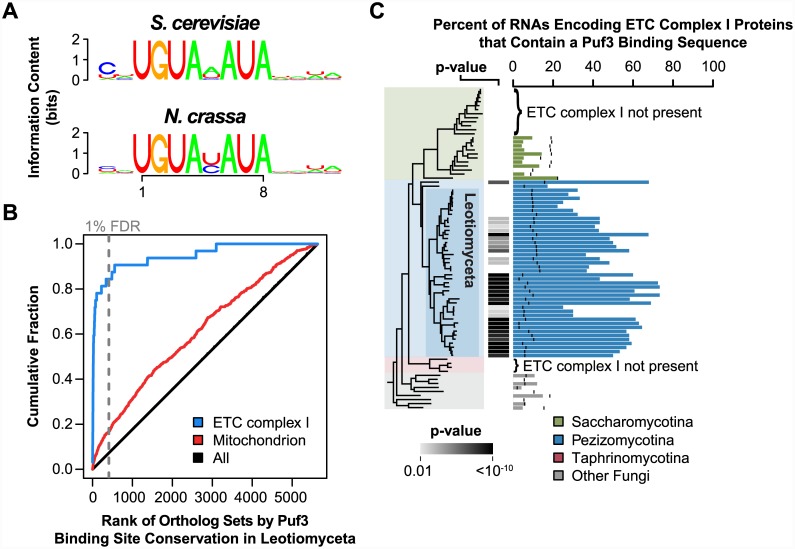
Binding specificity and targets of Leotiomyceta Puf3.(A) Motifs identified by the motif discovery program FIRE [82] within the 3' UTRs of S. cerevisiae mRNAs associated with S. cerevisiae Puf3 or the ectopically expressed N. crassa Puf3. FIRE identified eight nucleotide motifs, and these motifs were extended to display any preferences for flanking nucleotides. A match to the Puf3 motif UGUA[ACU]AUA is found in the 3' UTRs of 241 out of 392 (61%) of S. cerevisiae Puf3 targets and 83 out of 250 (33%) of mRNAs associated with N. crassa Puf3. The motif frequency across all 3' UTRs is 11%. Position frequency matrices can be found in S5 Dataset. (B) Cumulative distributions based on the ranked conservation score for Puf3 sites across Leotiomyceta species. The gray dashed line represents the 1% false discovery rate (FDR) cutoff for ortholog sets within which Puf3 sites are considered conserved. N. crassa annotations were used to define mitochondrion and electron transport chain (ETC) complex I groups [83]. Annotations and conservation scores can be found in S7 Dataset. (C) The percent of 3' UTRs of transcripts encoding components of ETC complex I that have a Puf3 binding site sequence. A black vertical bar marks the background frequency of the Puf3 motif for each species. A significant p-value indicates that Puf3 motif matches are enriched in complex I encoding RNAs relative to all other transcripts. The p-value was computed using Fisher's exact test and is corrected for multiple hypothesis testing. The multi-subunit, transmembrane complex I was independently lost in several fungal lineages, and species lacking this complex are noted. Percentages and p-values can be found in S1 Dataset.